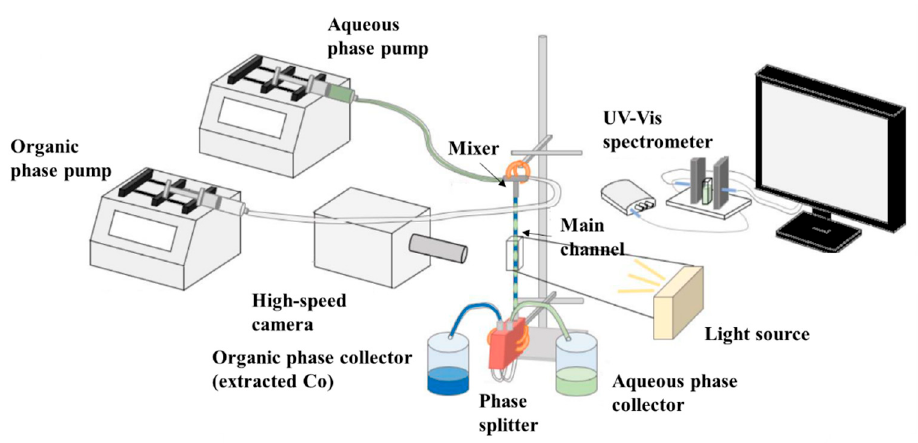
Figure 1. Schematic of the experimental setup for the continuous Co/Ni separation.